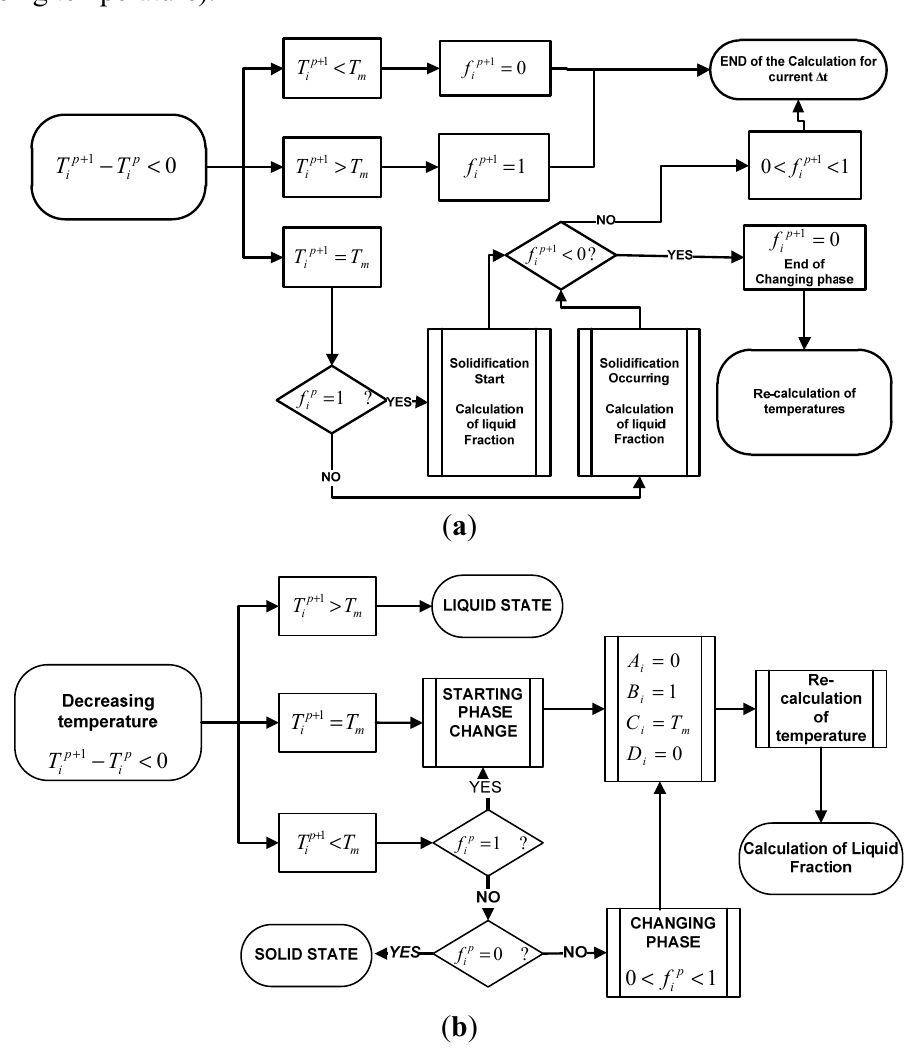
Figure 5. Flow diagram of ( a ) temperature calculation and ( b ) liquid fraction calculation (decreasing